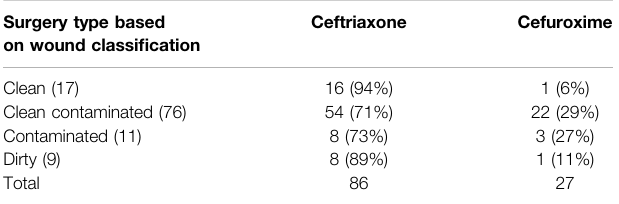
TABLE 4 | Pre-surgical use of ceftriaxone and cefuroxime based on wound classi fi cation. Surgery type based on wound classi fi